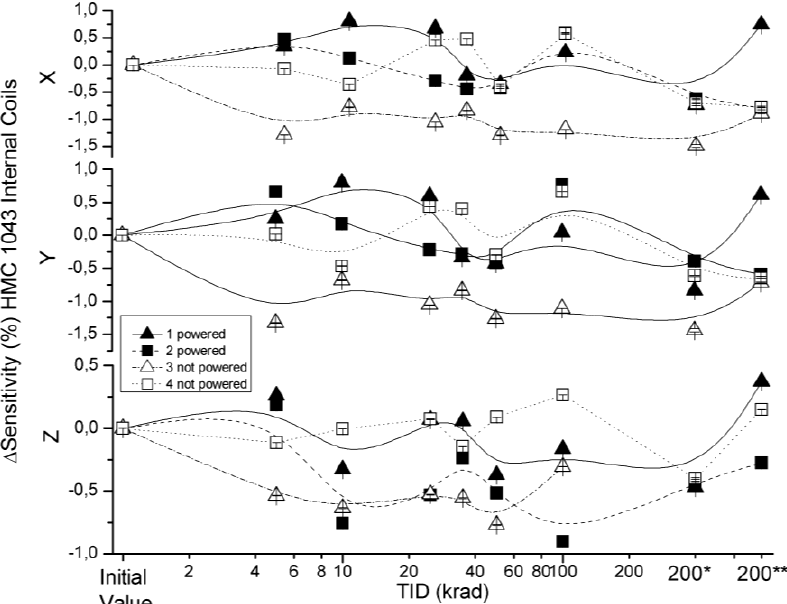
Figure 7. Sensitivity deviation measured for internal coils configuration as a function of TID for powered and non-powered HMC